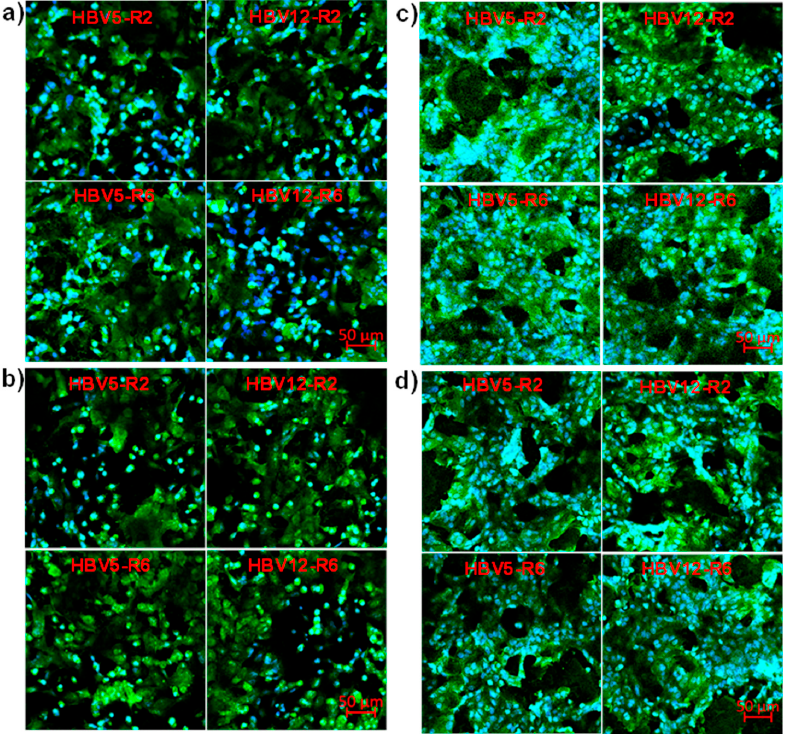
Figure 7. Fluorescence micrographs of NRK ( a , c ) and MDCK ( b , d ) epithelial cells after performing adhesion ( a , b ) and proliferation ( c , d ) assays onto HBV5 and HBV12 scaffolds obtained from 1,4-dioxane solutions cooled at rates of 2 and 6 °C/min. The green color is the actin marked with phalloidin and the blue color is the nucleus marked with DAPI.